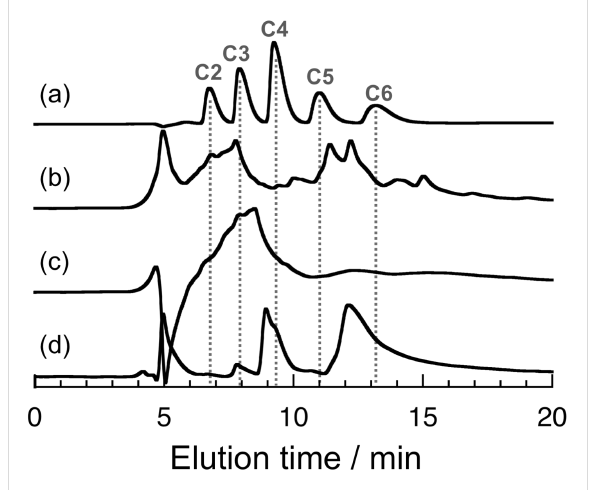
Figure 2: HPLC charts for standard samples (a) and products of the formose reaction in the absence (b) and presence of 10 mM SPB (c) and 20 g L − 1 pVPB/NaSS (d); the reaction times were 20, 90, and 180 min for (b), (c), and (d),